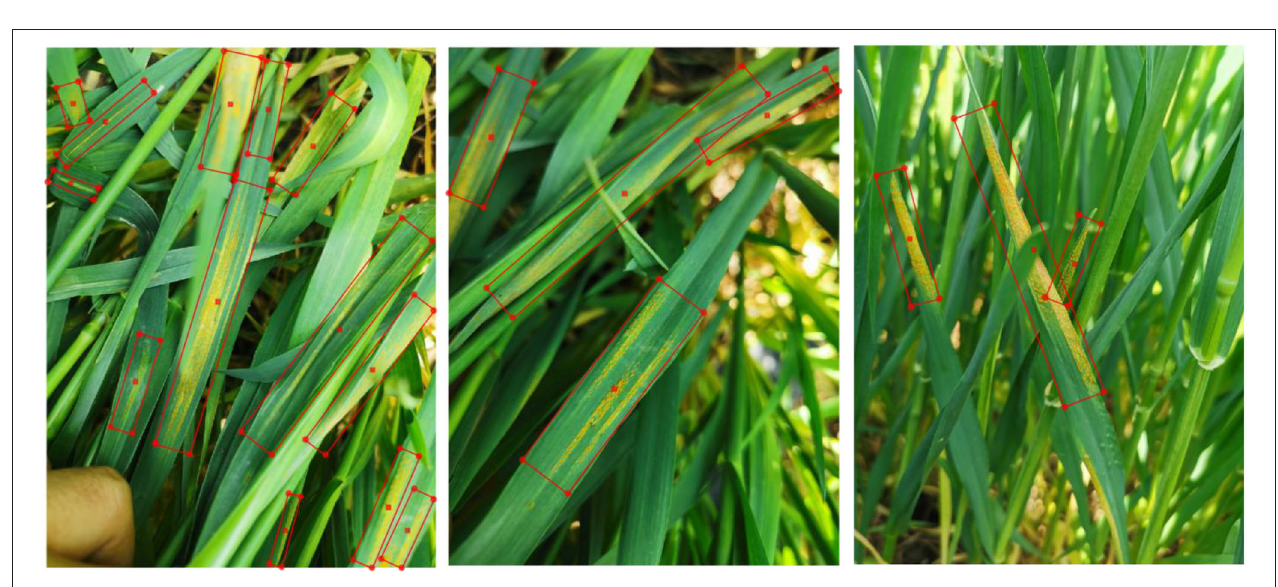
FIGURE 4 | Some examples of WSRD2021